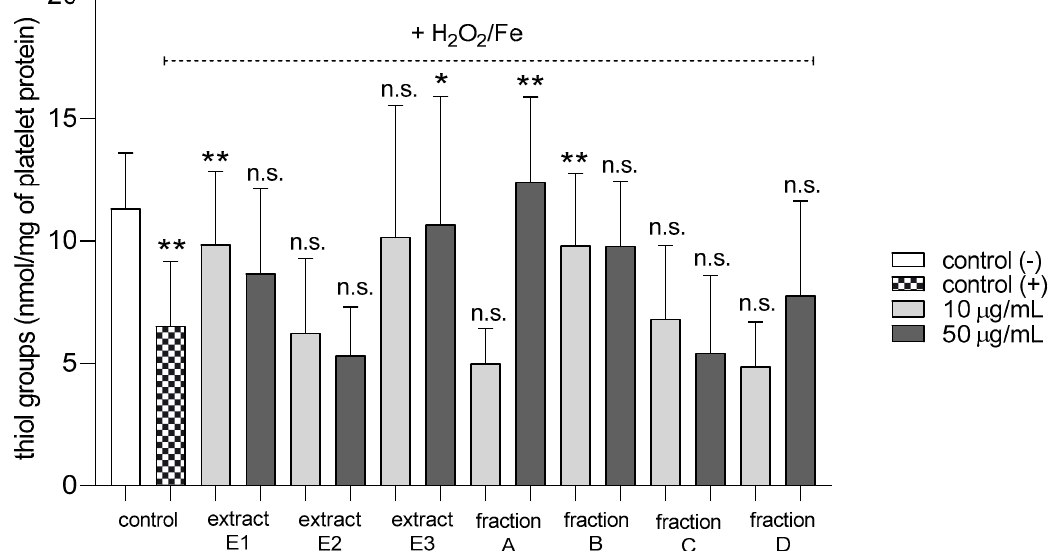
Figure 6. Effects of extracts (E1–E3) and flavonoid fractions (A–D) of dandelion fruits (concentrations 10 and 50 µg/mL) on the protein thiol group content of platelets treated with H 2 O 2 /Fe. The data are presented as means ± SD ( n = 5). Control negative refers to platelets not treated with H 2 O 2 /Fe, and control positive refers to platelets treated with H 2 O 2 /Fe. Kruskal-Wallis test: n.s. p > 0.05, * p < 0.05, ** p < 0.01, compared with positive control.